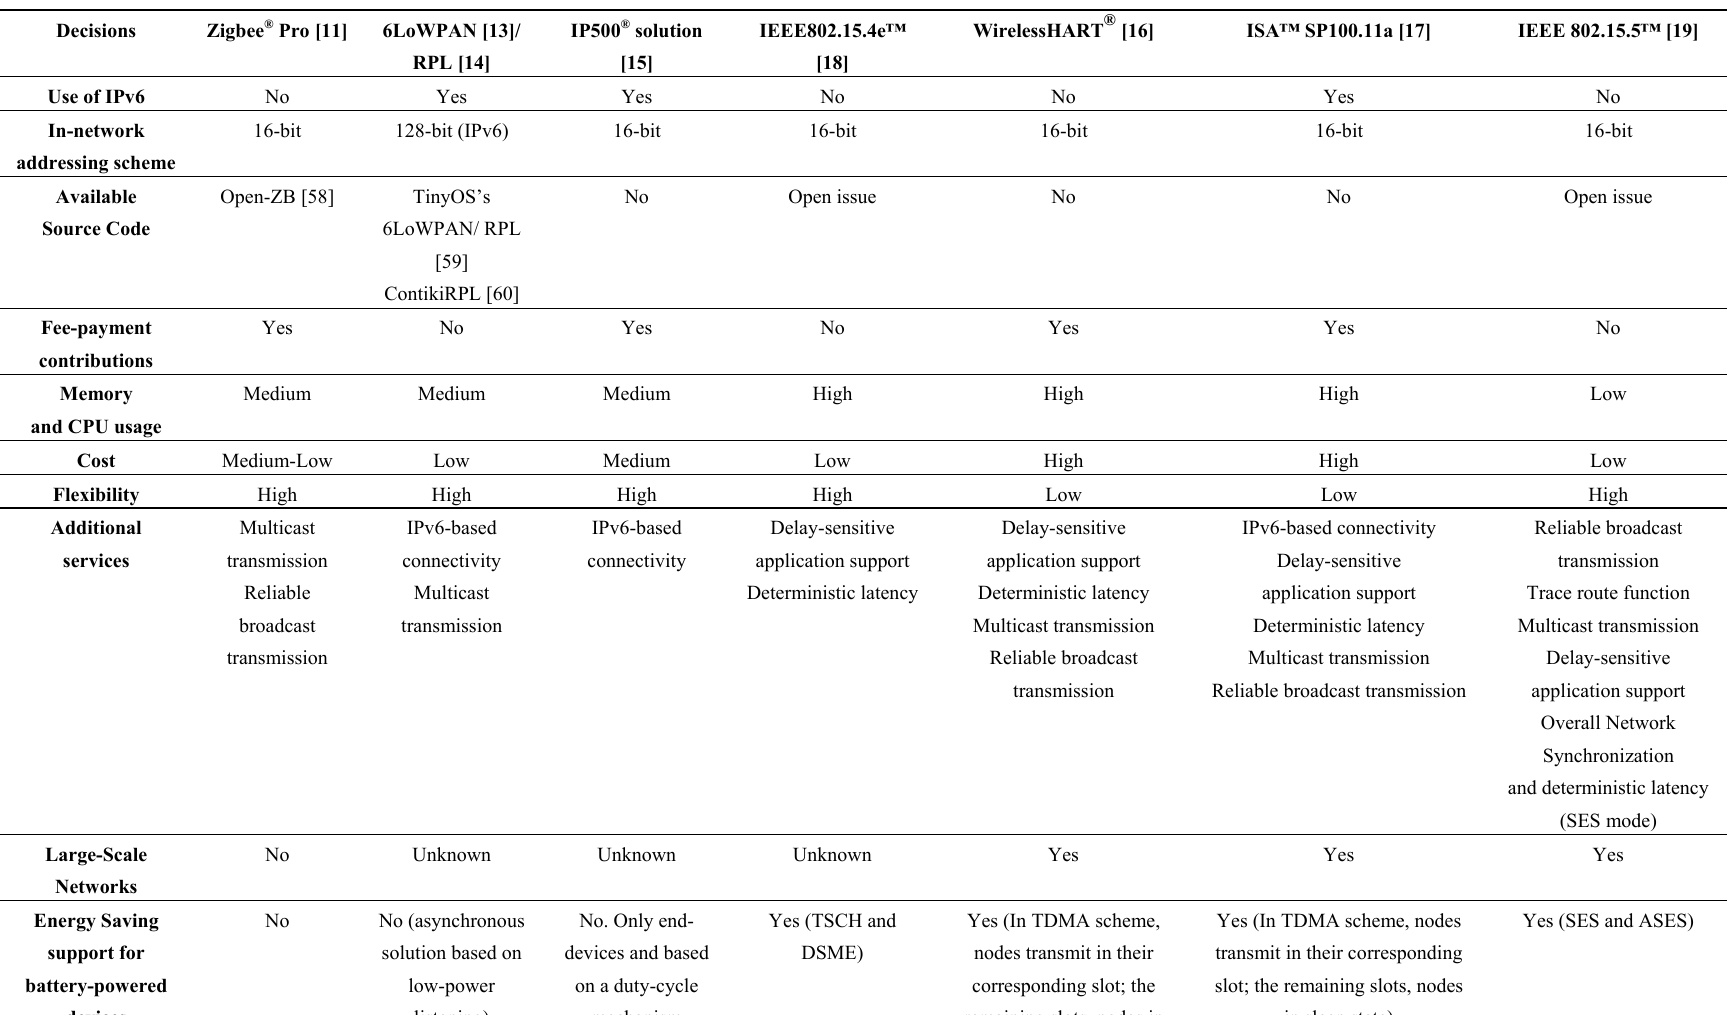
Table 2. Decision issues and classification of the current WMSN